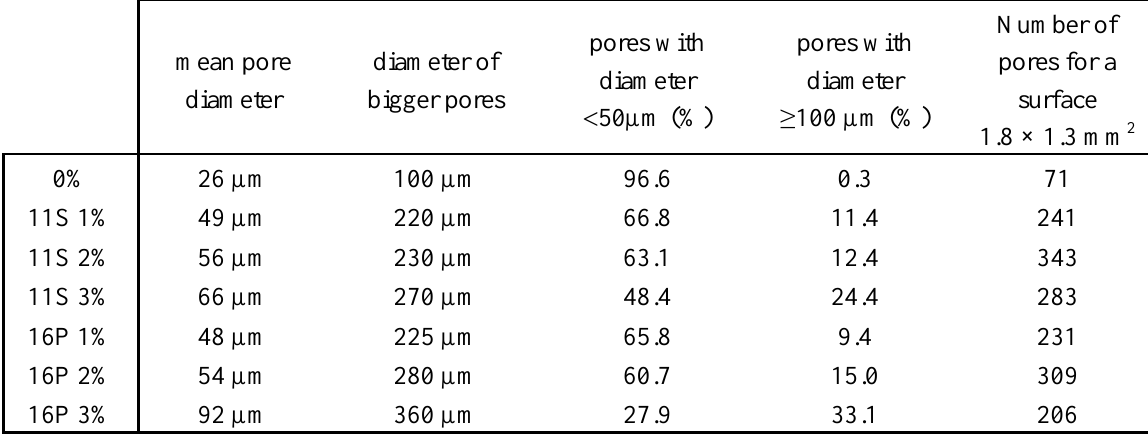
Table 3. Statistical analysis of pore size by image analysis of SEM